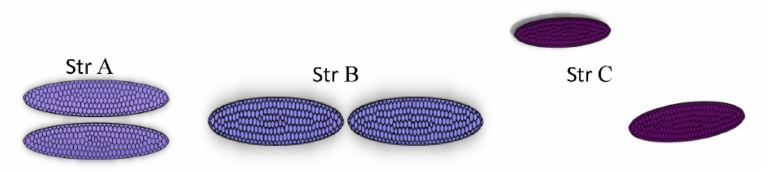
Figure 18. Structure of discharge multiport.